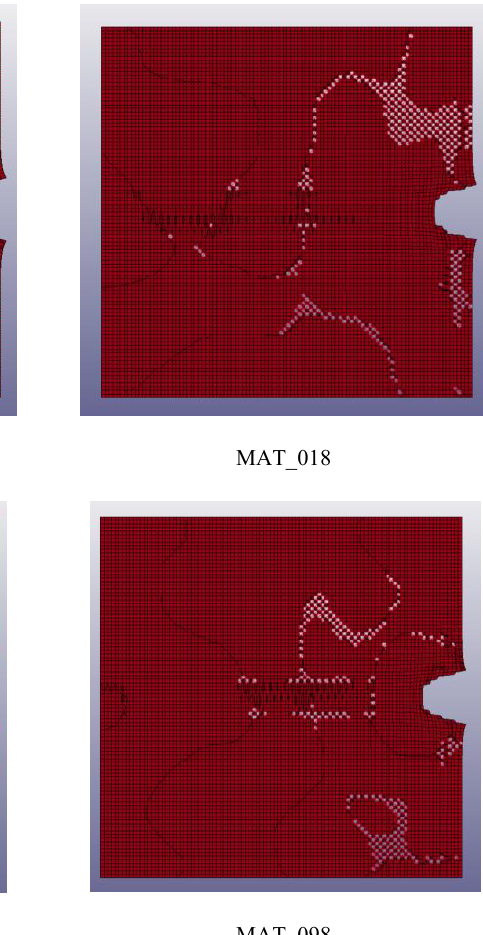
1000 V  m/s. Mesh size = 0